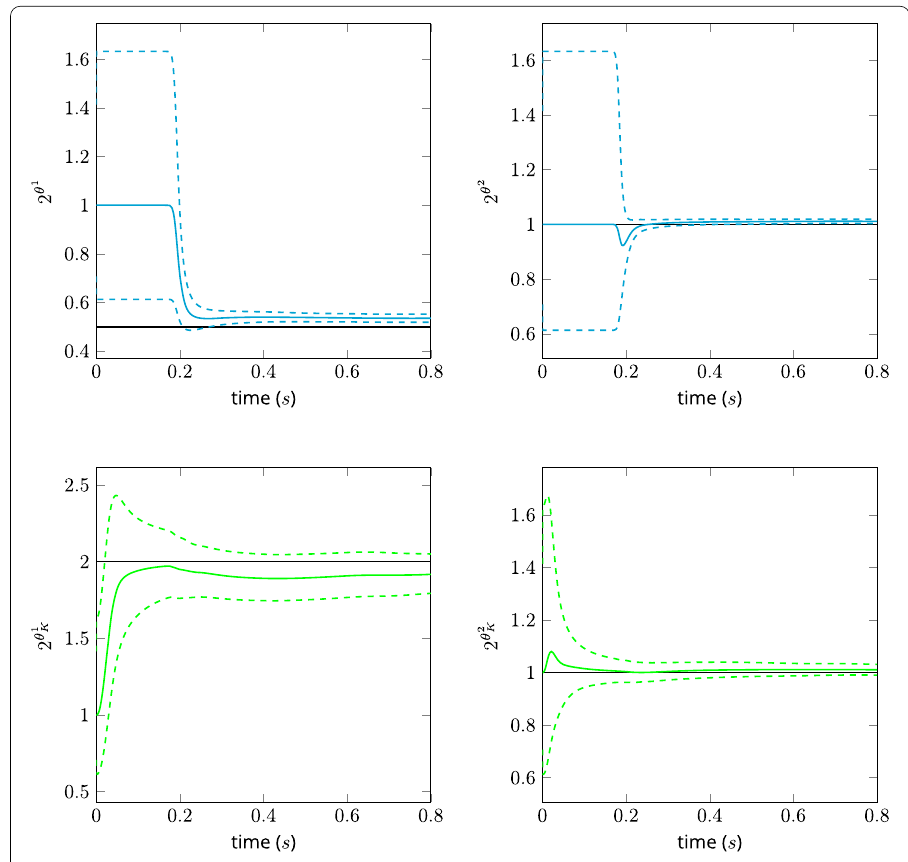
Fig. 13 Estimation of active (top) and passive (bottom) parameters using tag planes